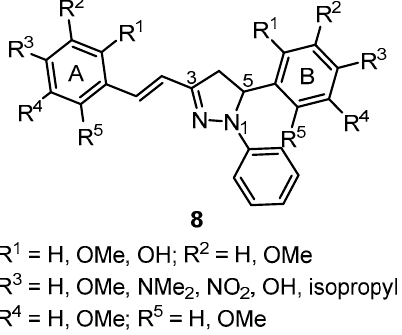
Figure 3. 3-Styryl-2-pyrazolines 8 presenting antibacterial and antifungal activity [34]. In the 2,2-diphenyl-1-picrylhydrazyl (DPPH) and horseradish peroxidase (HRP)/luminol/H 2 O 2